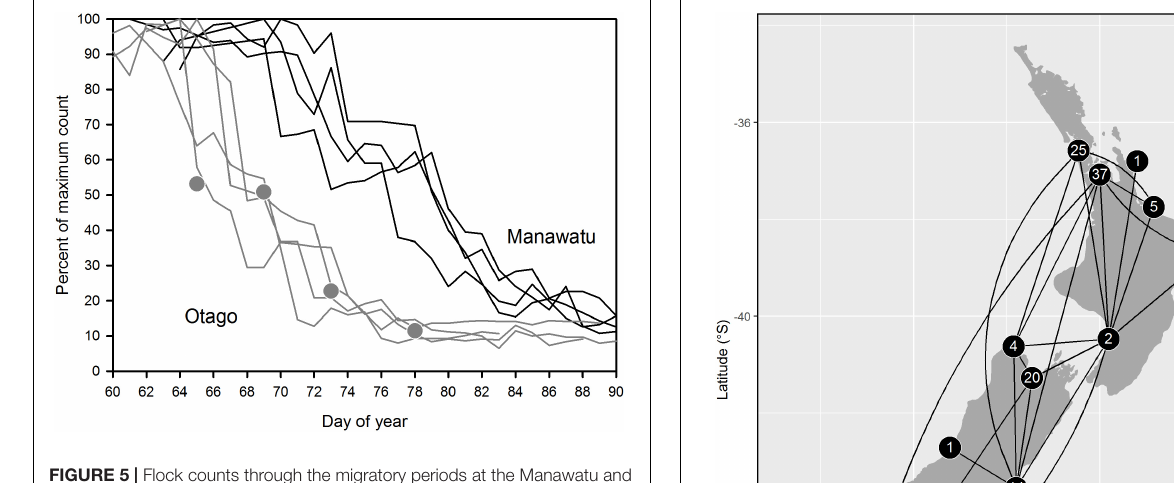
FIGURE 5 | Flock counts through the migratory periods at the Manawatu and Otago sites, 2013–2016. March 1 is represented by day 60 or 61 (the latter in a leap year). Gray circles represent the Avon-Heathcote Estuary, Canterbury, South Island, in 2017.